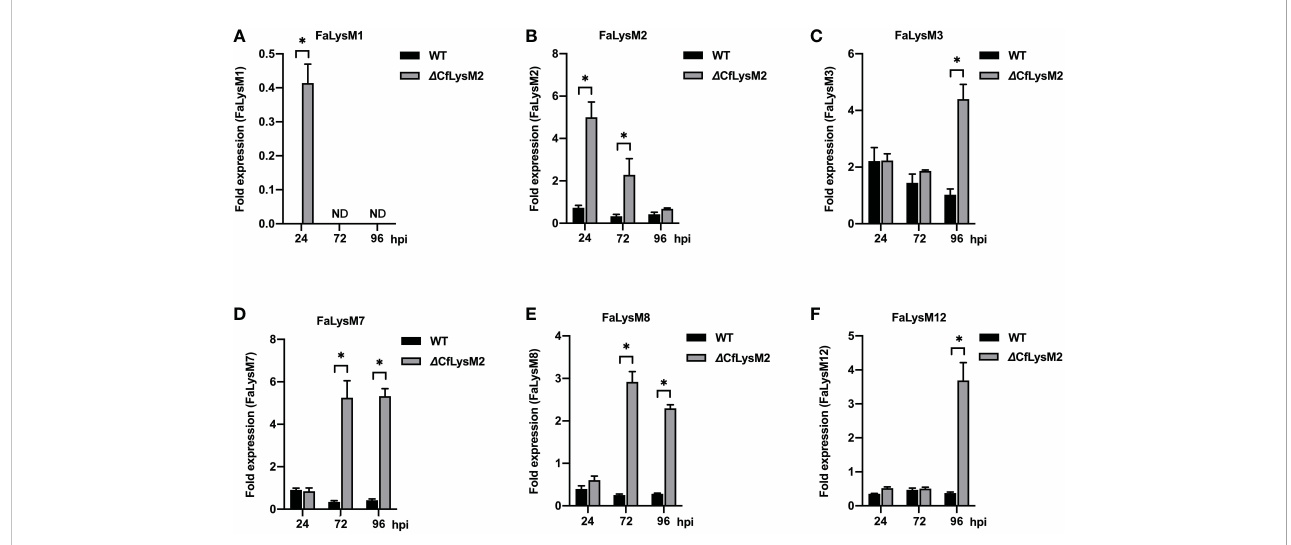
FIGURE 7 The relative expression levels of FaLysM genes in strawberry leaves infected with WT or D CfLysM2 of C. fructicola , respectively. Samples were collected at different time points (0, 24, 72, 96 hpi) for qRT-PCR analysis with FaLysM1 (A) , FaLysM2 (B) , FaLysM3 (C) , FaLysM7 (D) , FaLysM8 (E) , or FaLysM12 (F) primers, respectively. Y-axis shows the ratio of FaLysM gene expression in infected strawberry (24, 72, and 96 hpi) vs. mock inoculated strawberry. * Indicate P ≤ 0.05 (Student ’ s t